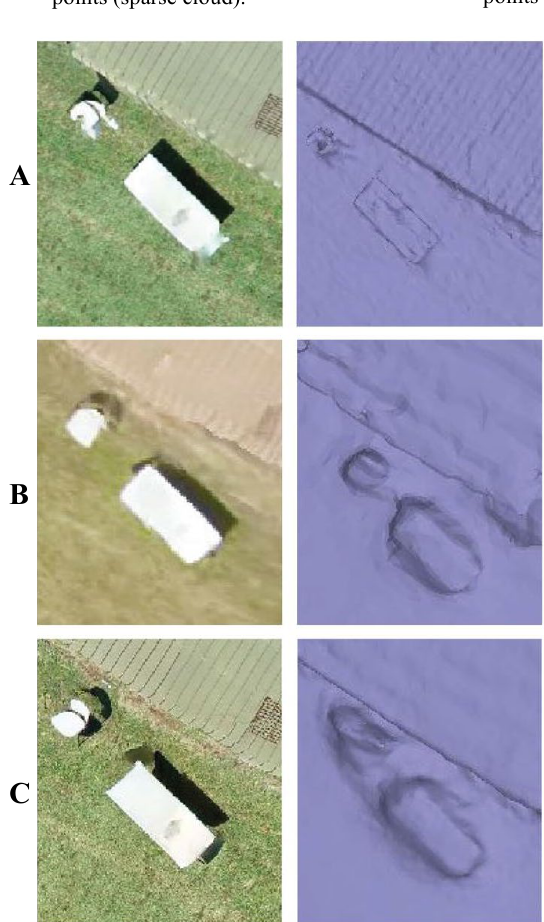
Figure 9. Scheme of the semi-nadiral and spherical images simultaneous